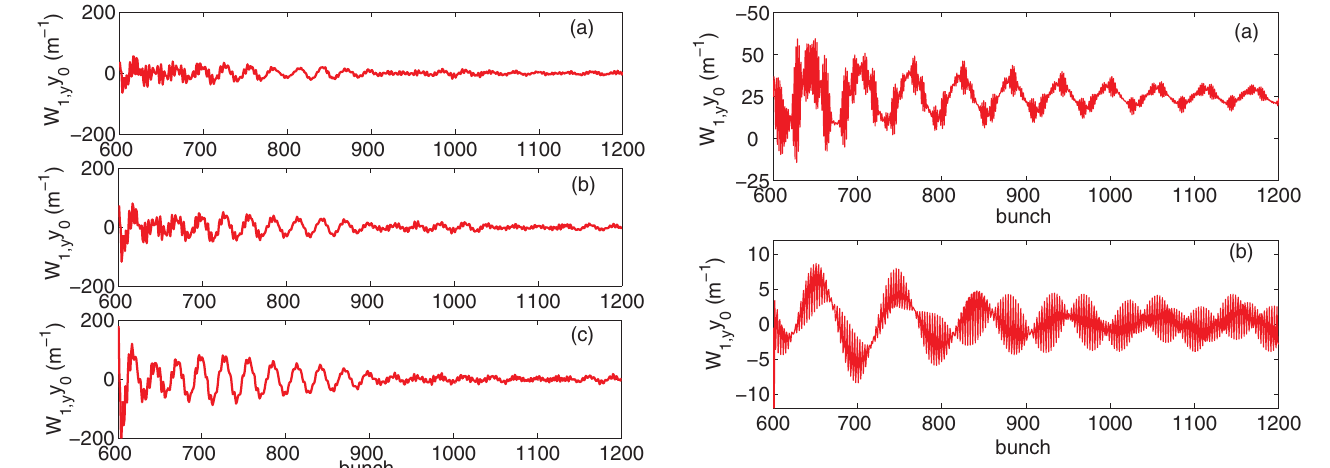
FIG. 10. (Color) Wake force for various displacements in a (cid:1) 10 G . Plots (a), (b), and (c) depict the solenoid field, B z wake force for displacements of the 600th of 1, 2, and 5 mm, respectively. Primary electrons are produced uniformly on the chamber surface and secondary ones are not